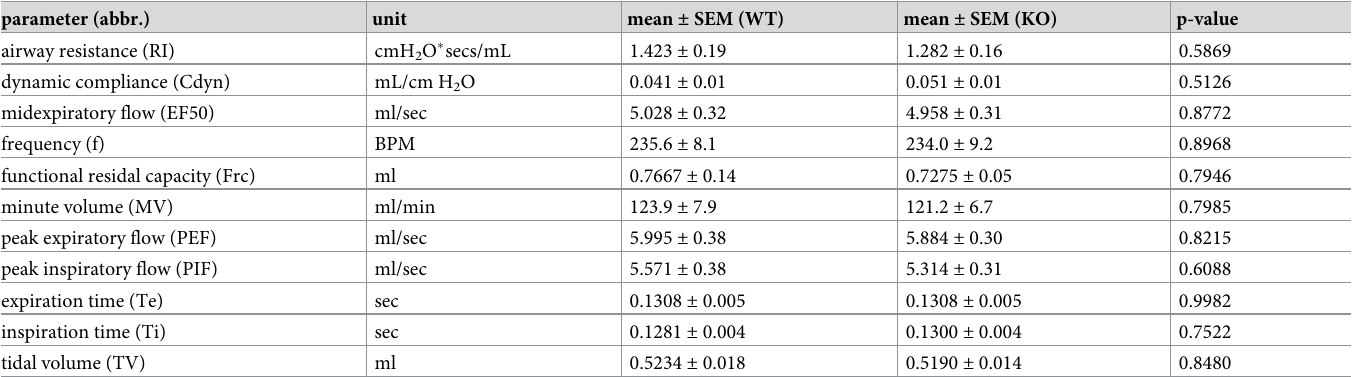
Table 1. Steady state lung parameters in wildtype and Lamp3 -/- mice. Airway resistance (RI) and dynamic compliance were measured in anesthetized and ventilated mice using FinePointe RC Units. Midexpiratory flow (EF50), frequency (f), functional residual capacity (Frc), minute volume (MV), peak expiratory flow (PEF), peak inspiratory flow (PIF), expiration time (Te), inspiration time (Ti), and tidal volume (TV) were measured in conscious, spontaneously breathing mice using FinePointe non-invasive airway mechanics (NAM) double chamber plethysmography. Values displayed as mean ± SEM, n = 7 per genotype. parameter